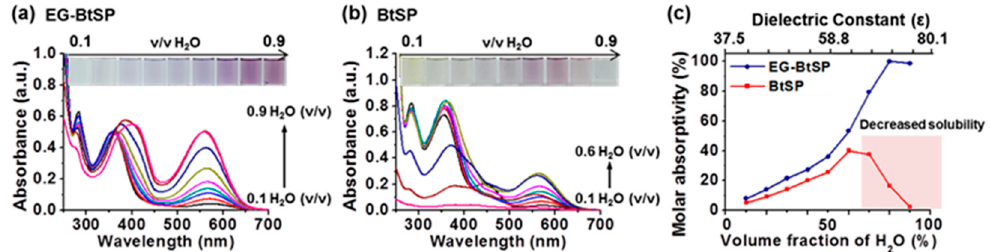
Figure 2. ( a , b ) UV-absorption spectra of EG-BtSP (a, c = 5 × 10 − 5 M) and BtSP (b, c = 1 × 10 − 4 M) in different water/CH 3 CN mixtures from 1/1 to 9/1 ( v / v ) at 25 °C. Color changes of the solutions were also presented; ( c ) Relative molar absorptivities of EG-BtSP and BtSP at 564 nm were compared according to the volume fraction of water in CH 3 CN.